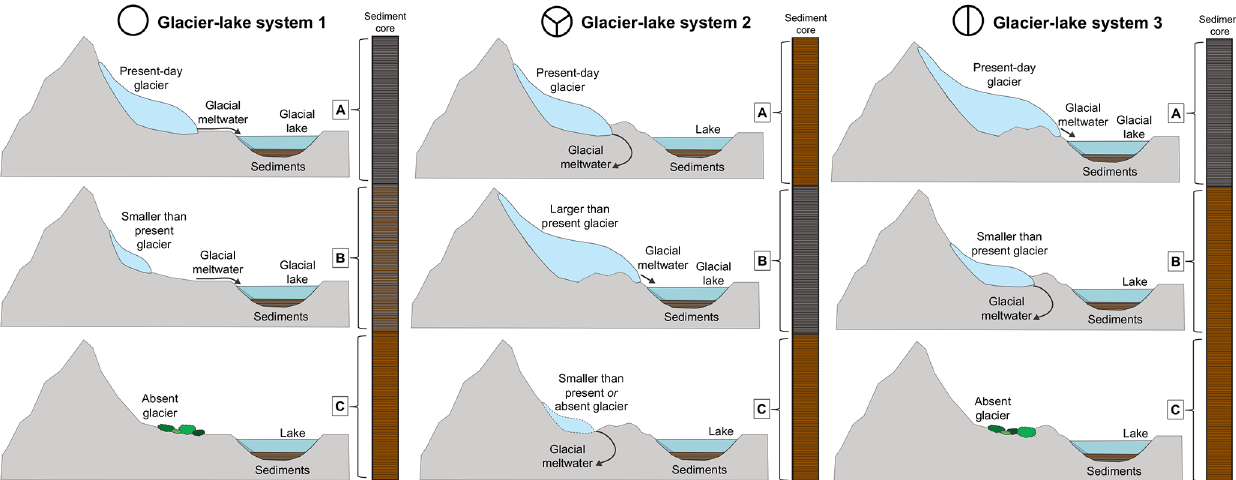
Figure 2. Schematic of common glacier–lake systems and resulting lake sediment stratigraphies. Left panel: the entire glacier resides within the lake’s catchment and glacial meltwater enters the lake at present. Lake sediment records glacier presence (A: fine-grained, gray minerogenic-rich sediment), absence (C: brown organic-rich sediment), and potentially more subtle variations in glacier size over time (e.g., B: an intermediate sediment type). Middle and right panels: classic “threshold lake” settings in which overtopping of and/or retreat behind a topographic threshold creates an “on–off” signal. In system type 2, the glacier is not currently in the lake’s catchment and glacial meltwater does not enter the lake at present. Lake sediments can record when the glacier was larger than present and crossed the topographic threshold (B: fine-grained, gray minerogenic-rich sediment), as well as when the glacier was at its present-day size, smaller, or absent and thus behind the topographic threshold (A and C: brown organic-rich sediment). In this setting, whether a glacier was at present-day size (2A), smaller than present, or absent (2C) may be indistinguishable from the sediment record. In system type 3, glacial meltwater enters the lake at present. Lake sediments record glacier presence at present-day size (A: fine-grained, gray minerogenic-rich sediment) and when the glacier was either absent or smaller than present and retracted behind the topographic threshold or exited the lake’s watershed (B and C: brown organic-rich sediment). In this setting, retracted glacier size (3B) may be indistinguishable in the lake sediment record from glacier absence